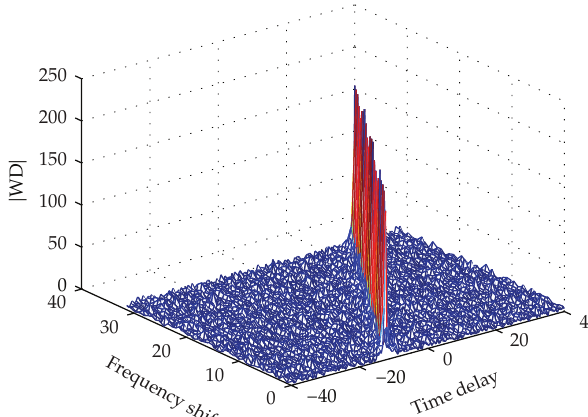
Figure 4: The WDL of f (cid:4) t (cid:5) with SNR (cid:7)